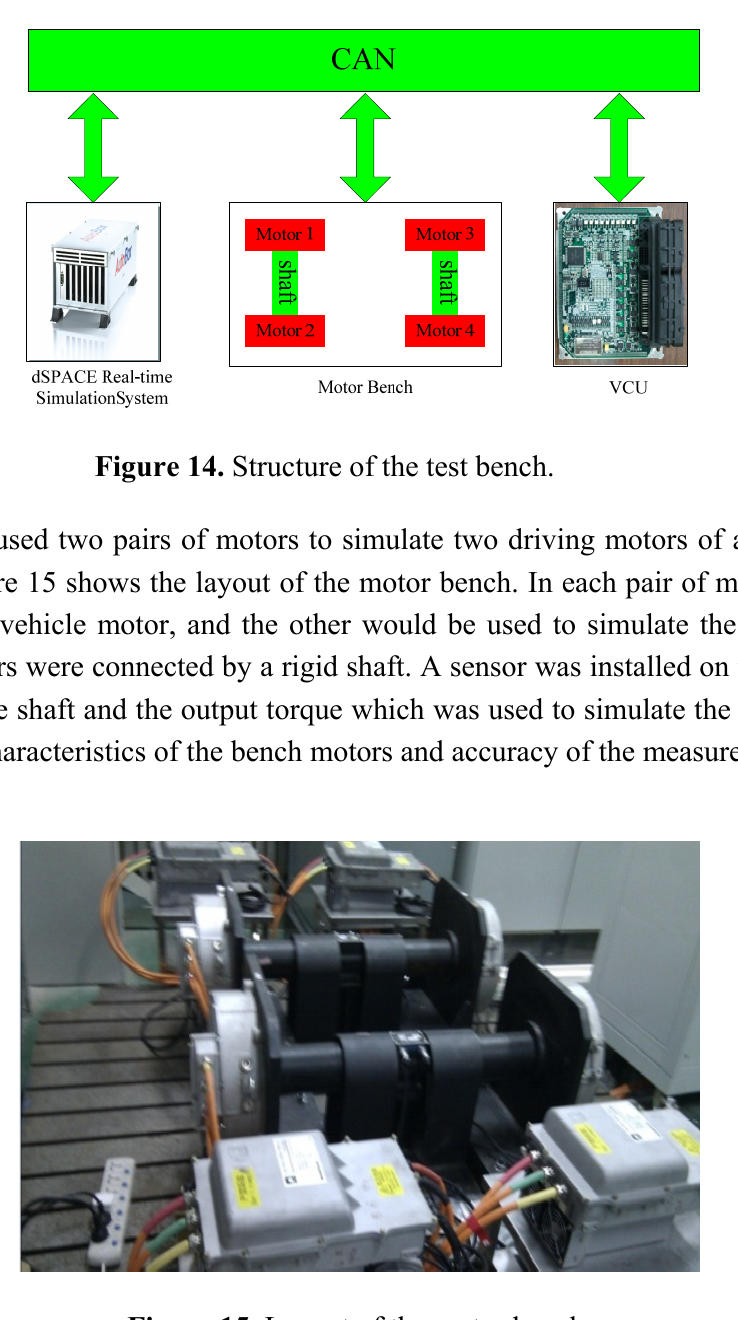
Figure 15. Layout of the motor